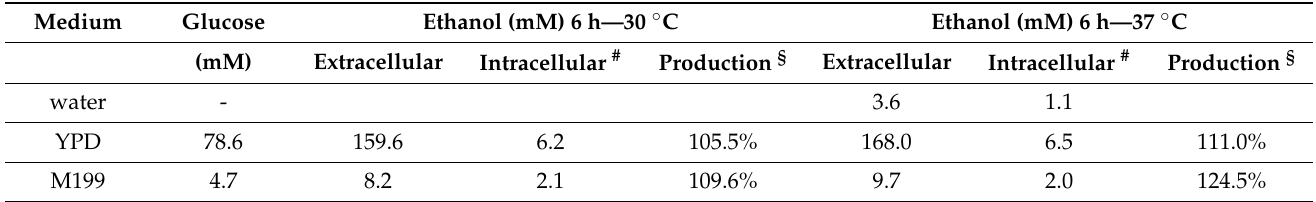
Table 1. Glucose availability and ethanol net production in water, YPD, and